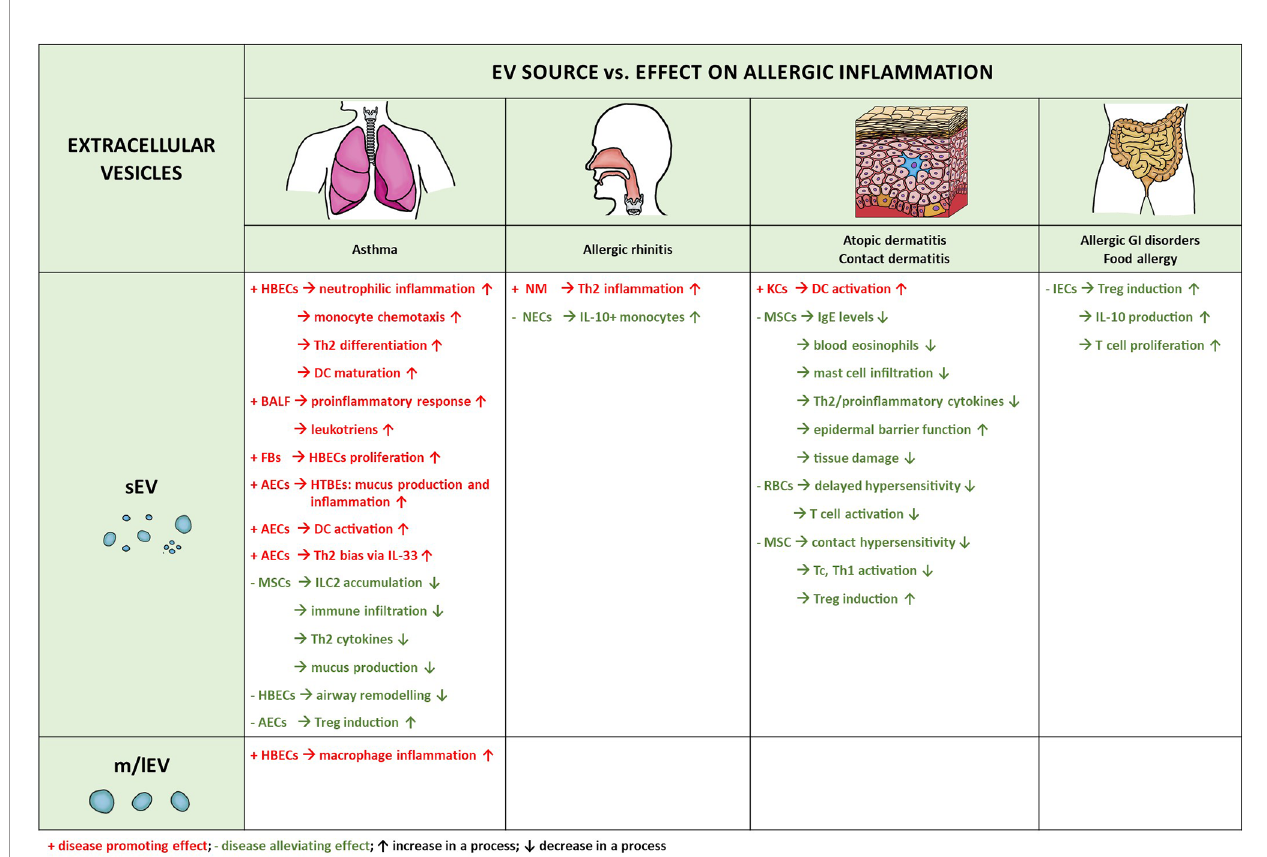
FIGURE 3 | Extracellular vesicles produced by non-immune cells and their involvement in allergic diseases. Microvesicles and exosomes are the two types of extracellular vesicles which have been implicated in the pathogenesis of allergic in fl ammation. There is signi fi cant predominance of the exosomal involvement, likely due to the phenotypic characteristics and physical properties of these vesicles, enabling more without damage and entering the circulation for long-distance delivery. HBECs, human bronchial epithelial cells; BALF, bronchoalveolar lavage fl uid; NM, nasal mucus; NECs, nasal epithelial cells; AECs, airway epithelial cells; HTBEs, human tracheobronchial cells; RBCs, red blood cells; IECs, intestinal epithelial cells; KCs, keratinocytes; FBs, fi broblasts; MSCs, mesenchymal stem cells. ↑ increase in a process; ↓ decrease in a process; + disease promoting effect; - disease alleviating